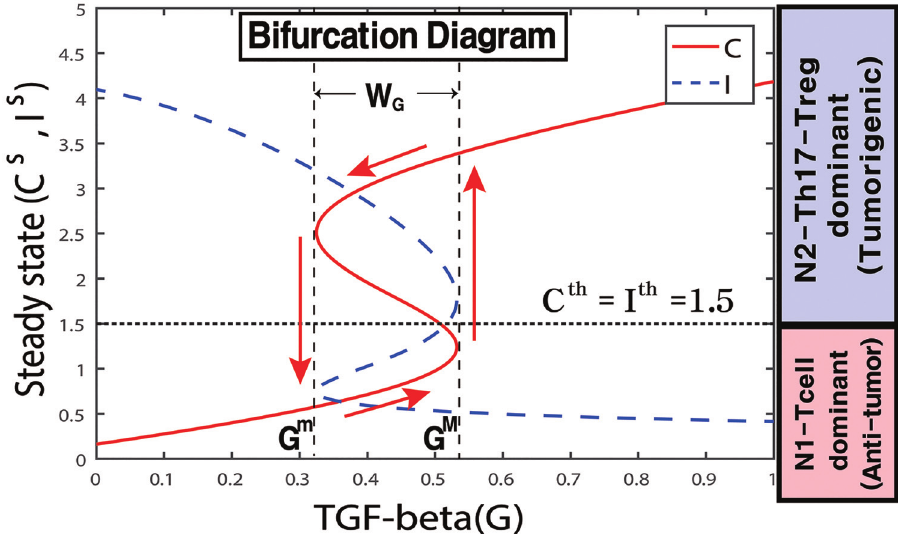
Fig 6. Bifurcation diagram. High and low TGF- β signals ( G ) provide an on-off switch of N2 activation and determine the dichotomous behavior: cancer cell activation and benign status. Y-axis = steady state (SS) of levels of the N2 ( C ) and N1 ( I ) complex modules. W G = [ G m , G M ] = a window of bi-stabilty. S = 0.2. Other parameters are given in Table